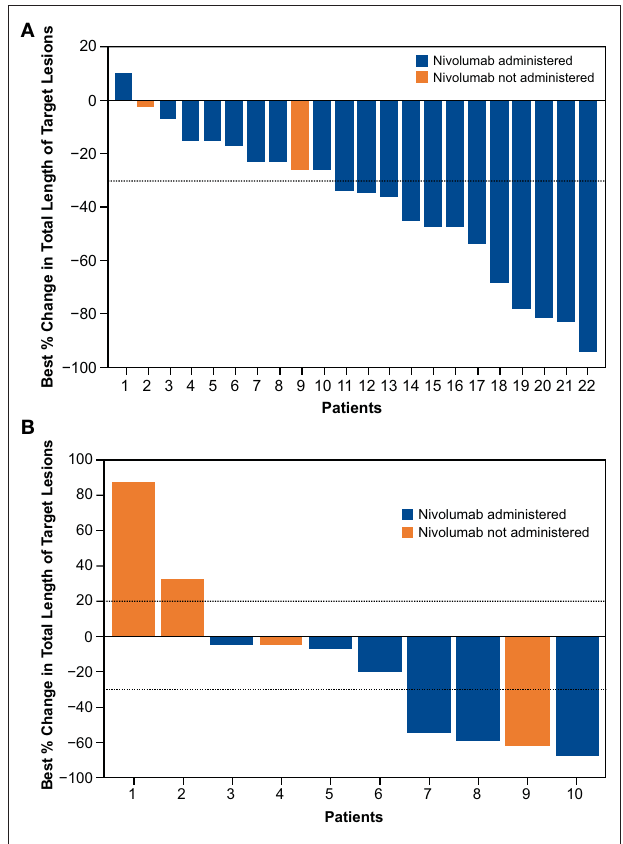
FIGURE 5 | Change in total length of target lesions from baseline up to initial progression for individual patients in concurrent cohort (dose-finding and expansion parts; A ) and delayed cohort (dose-finding part only; B